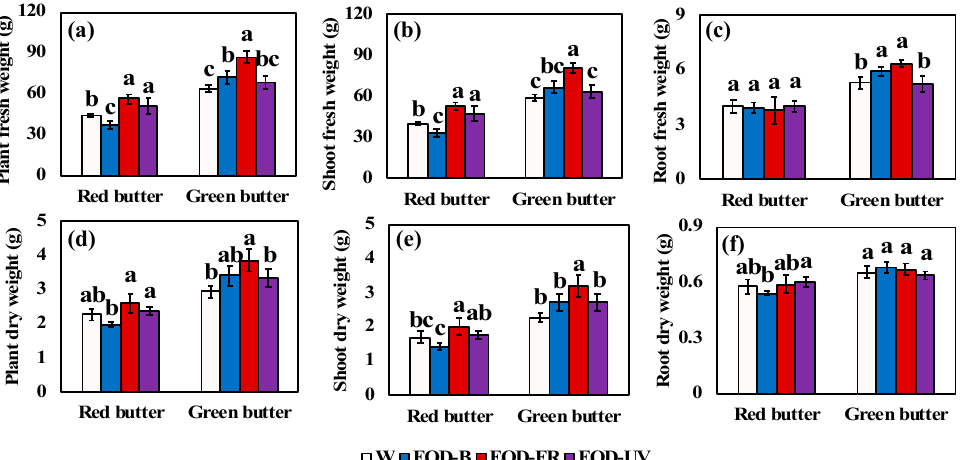
Figure 3. Biomass of lettuce under different end-of-day lightings. Fresh weight of plant ( a ), shoot ( b ), and root ( c ). Dry weight of plant ( d ), shoot ( e ), and root ( f ). Different letters on the top of the columns indicate significant differences at p < 0.05 according to one-way ANOVA, Tukey’s honestly significant difference tests. W= day-white light, EOD-B = end-of-day enhanced blue light, EOD-FR = end-of-day far-red light, EOD-UV = end-of-day ultraviolet-A light. Table 2. The interaction effects of cultivars and lightings on lettuce biomass.